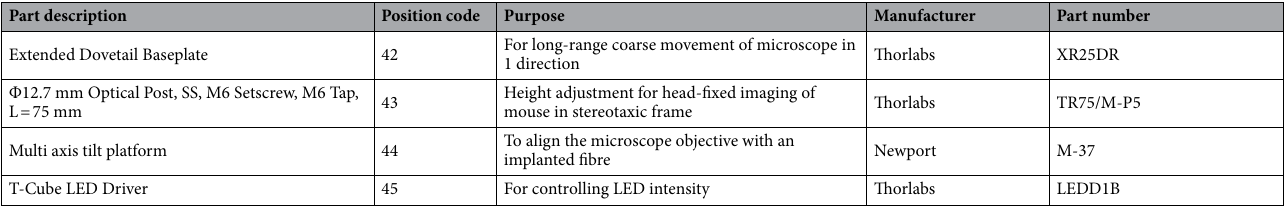
Table 1. Material list for microscope